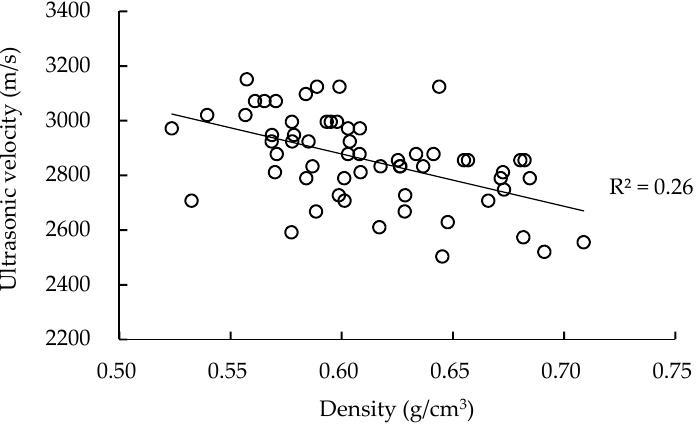
Figure 10. Relationship between the ultrasonic velocity and density of poplar seedlings.